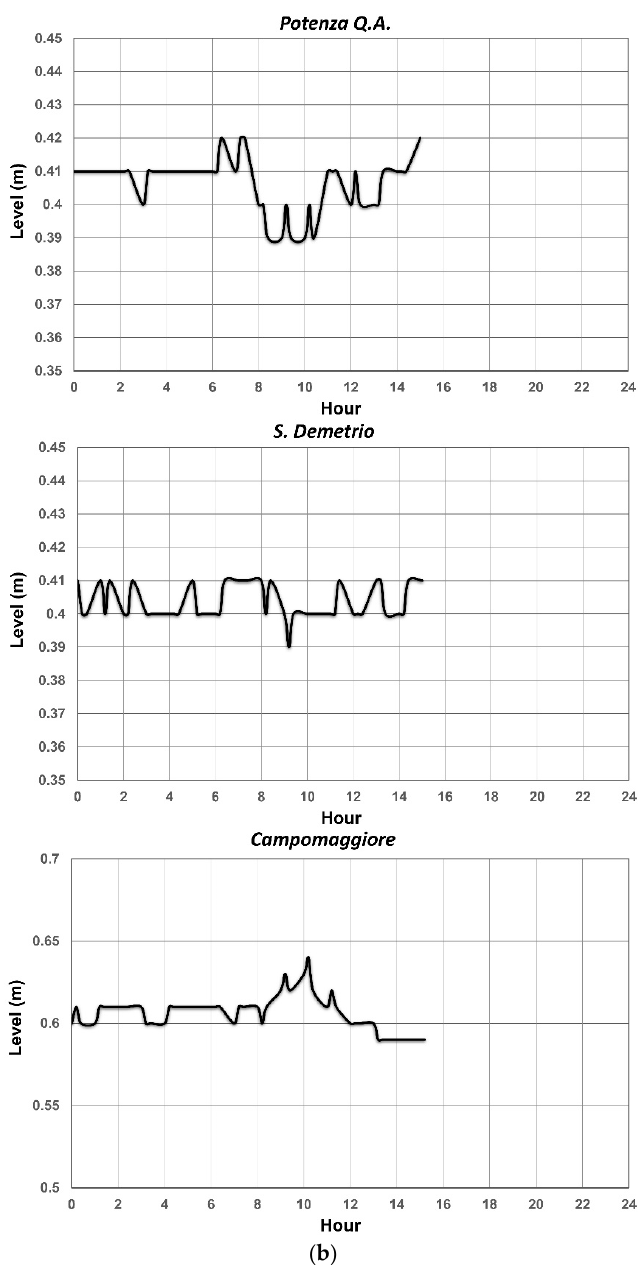
Figure 4. ( a ) Comparison among real-time plots of hydrometric levels trends recorded by multiple stations; ( b ) The plots generated from the regional Civil Protection.